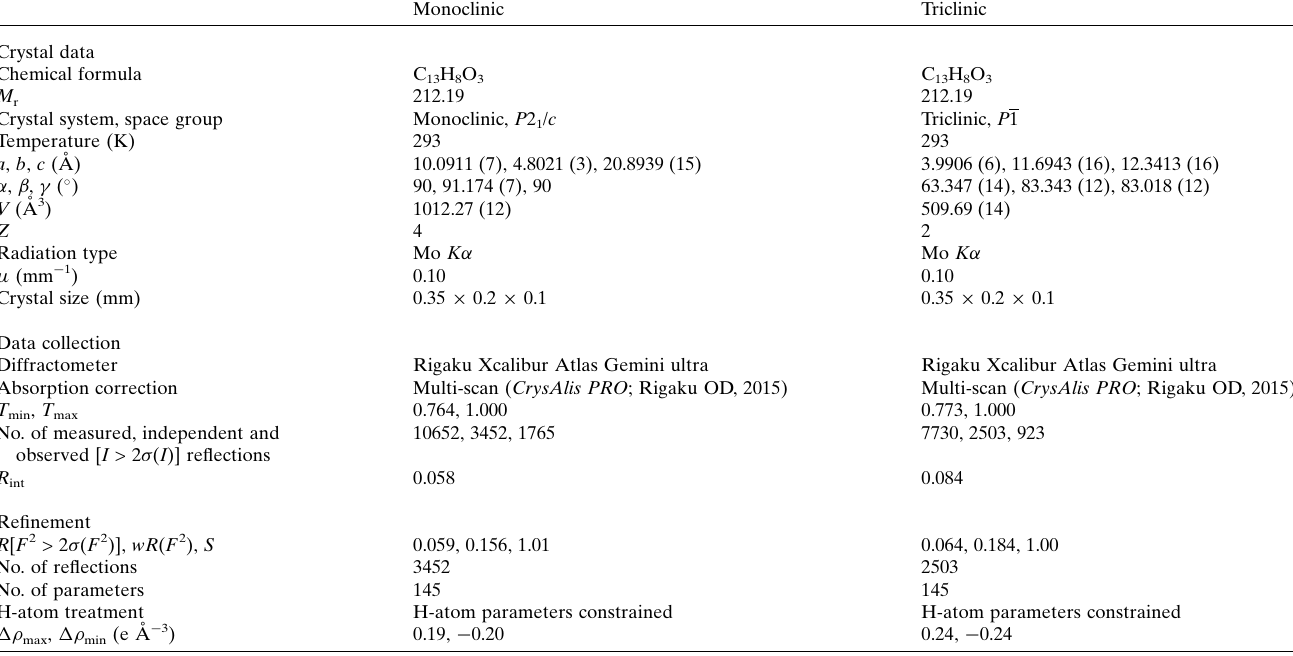
Table 2 Experimental